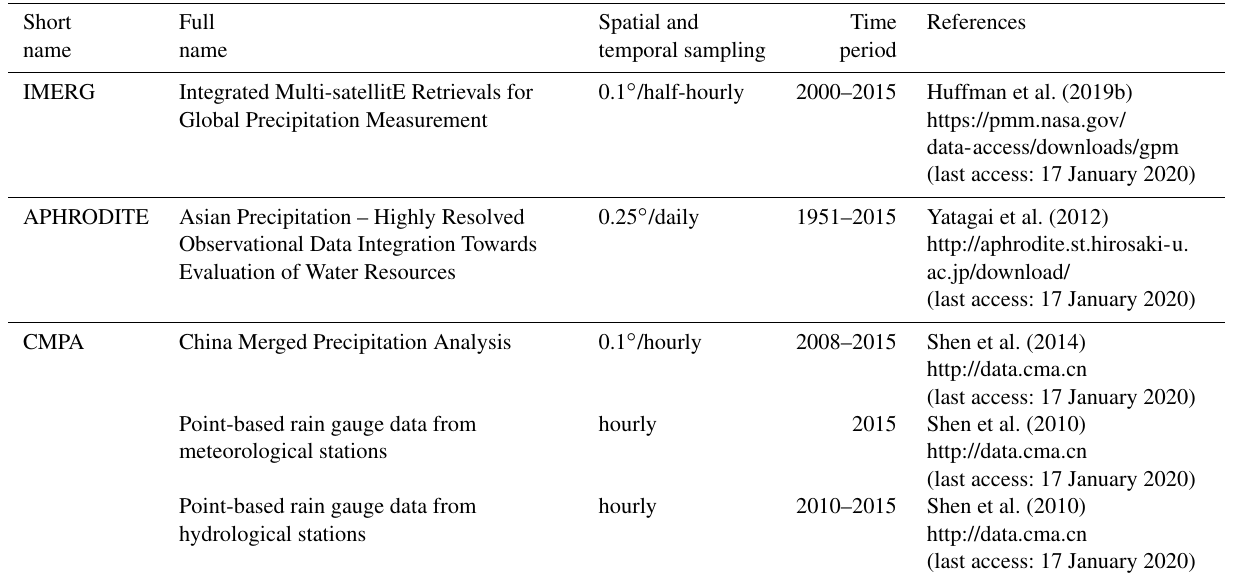
Table 1. List of satellite-based, gauge-based, and satellite–gauge combination precipitation products used in this study. Short Full Spatial and